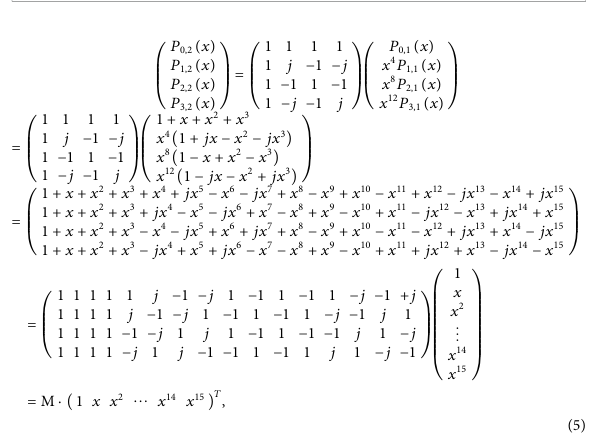
FIGURE 3 Diffuse scattering diagram of the metasurface in the plane wave with the incident angle θ